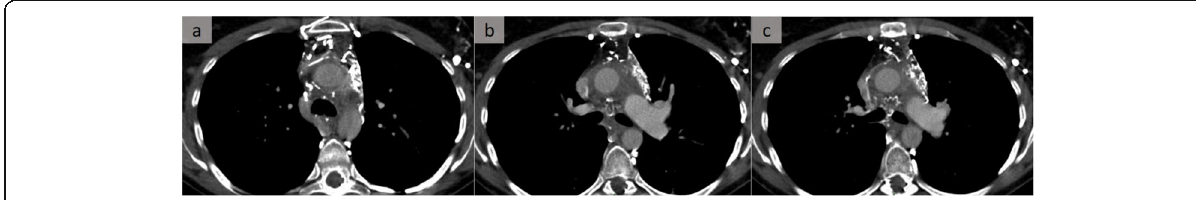
Fig. 11 IgG4-related mediastinitis. A patient with fibrosing mediastinitis as an unusual mediastinal manifestation of IgG4-related disease. Three successive axial slices ( a – c ) show diffuse infiltration of the mediastinum with collaterals due to occlusion of the systemic